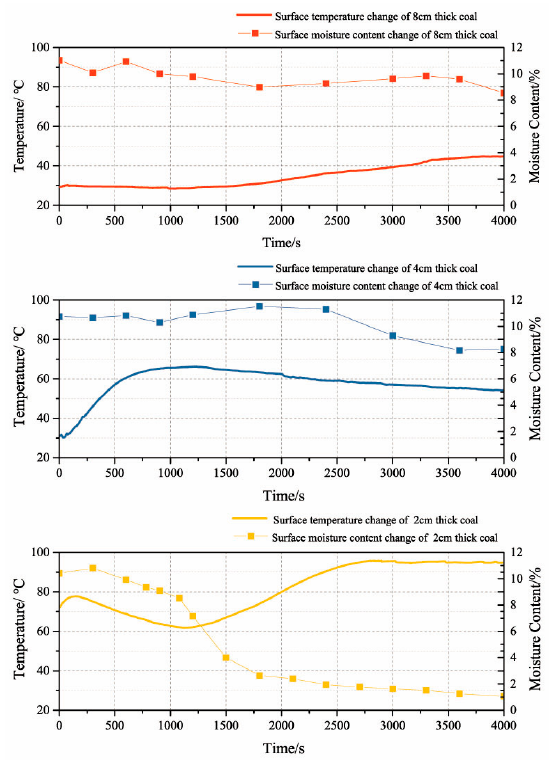
Figure 5. Surface temperature and moisture content change of different thickness coal in thin-layer drying experiment.